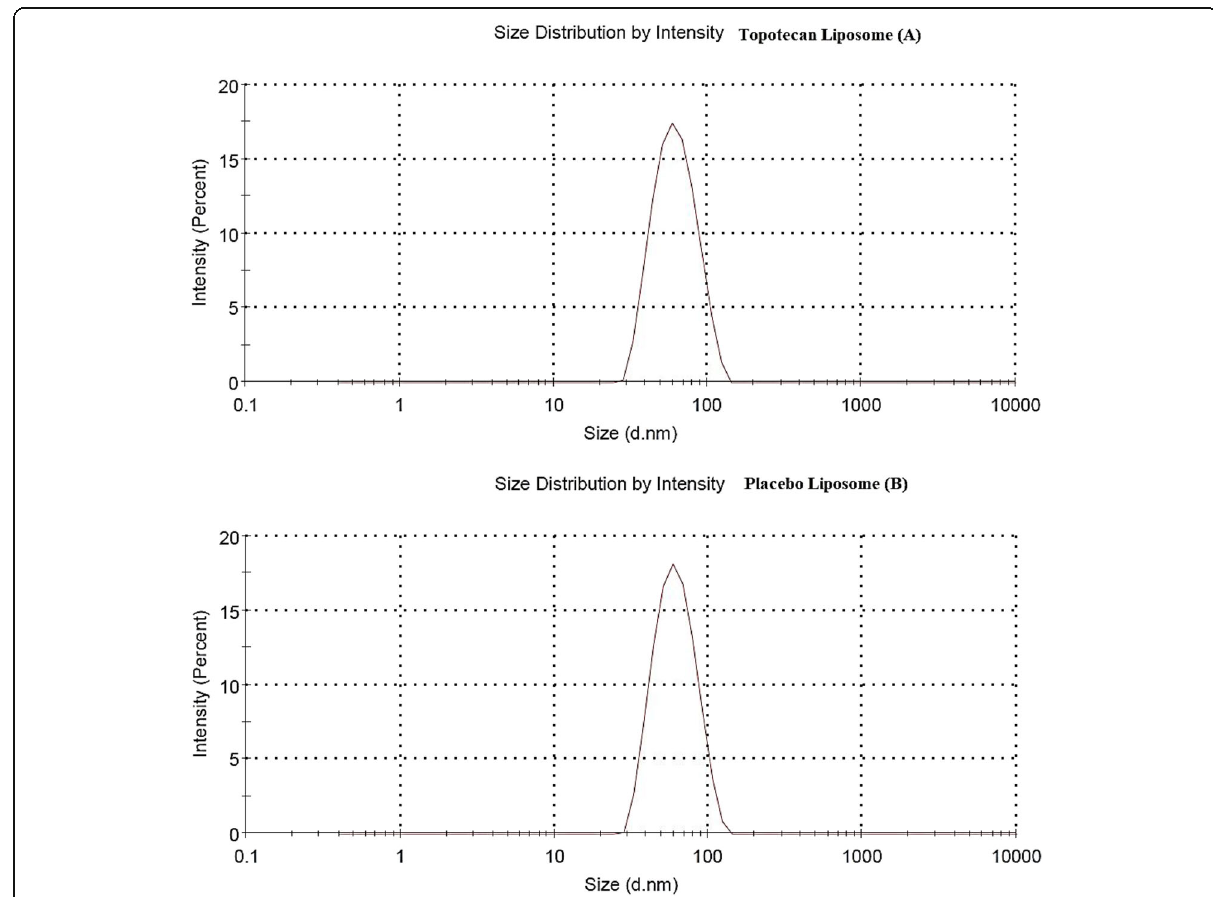
Fig. 8 Dynamic light scattering (particle size) of a topotecan liposome and b placebo